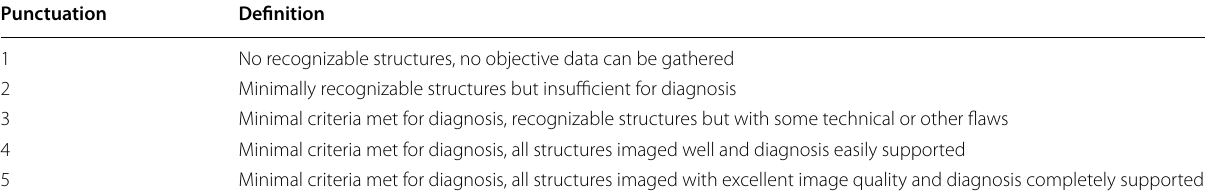
The scale consists of five levels. 1 is the lowest grade: image fails to recognize anatomical structures and therefore does not allow a diagnosis. 2 recognizes anatomical structures but not enough to make a diagnosis. 3 image allows a diagnosis, but there are certain failures in the image’s position or image gain and depth. 4 and 5 , diagnostic is supported by images of good and excellent quality, respectively